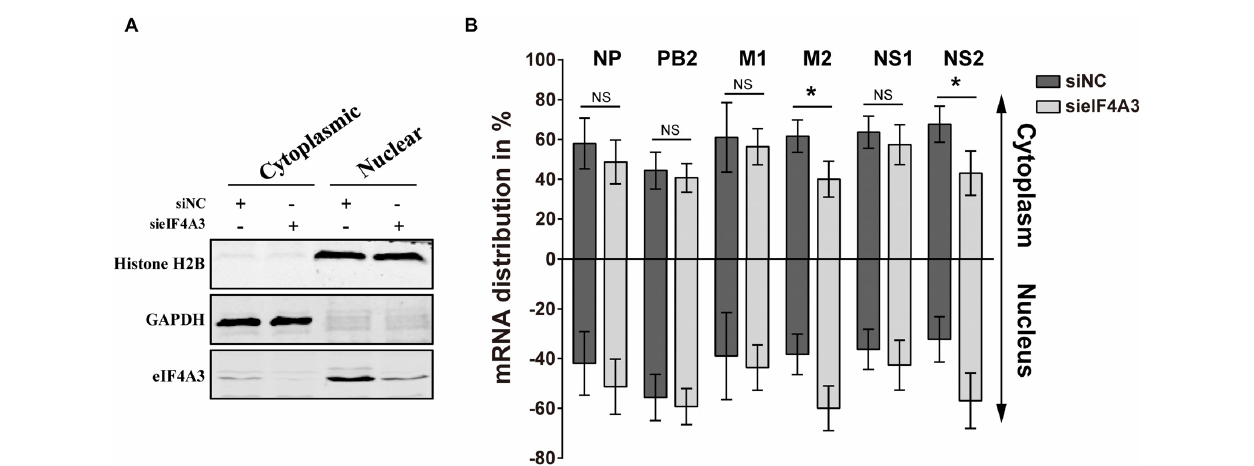
FIGURE 7 | Reduced export of viral spliced mRNA in cells treated with eIF4A3 specific siRNA upon infection with AIV. A549 cells were treated with the NC (dark gray bars) or eIF4A3 (light gray bars) siRNAs for 36 h and subsequently infected with influenza virus V at an MOI of 5 for 4 h. Cytoplasmic and nuclear extracts were isolated and poly(A)+ mRNAs were purified. (A) The purity of the cytoplasmic and nuclear fractions was monitored by Western blot using antibodies specific for GAPDH or Histone H2B, respectively. (B) The levels of viral mRNA were quantified by RT-qPCR, normalized to 18srRNA. The data are shown as means ± SD ( n = 3) and the significance was calculated using an unpaired t -test ( ∗ p <